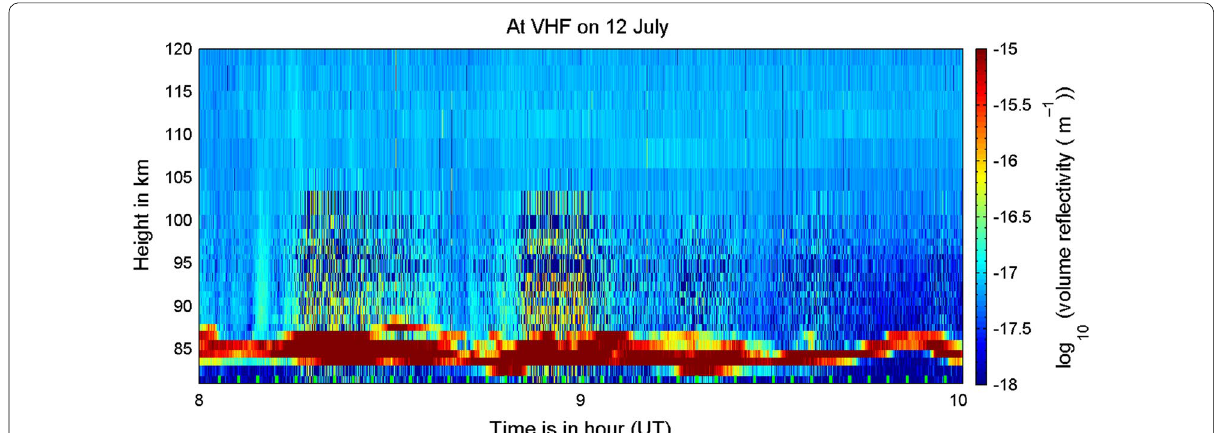
Fig. 11 An example of VHF PMSE observations in the presence of particle precipitation. The vertical green bars indicate the heater-on period